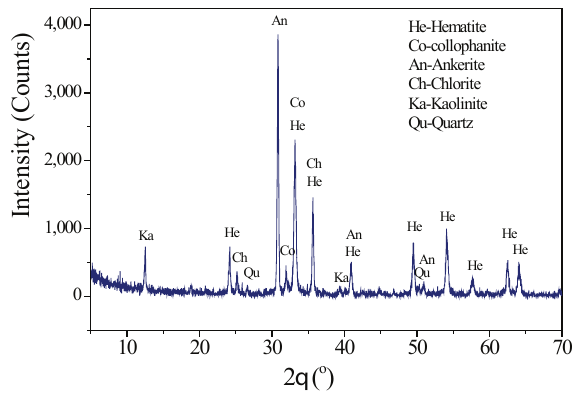
Figure 2: A Typical XRD pattern to show the raw oolitic iron ore.